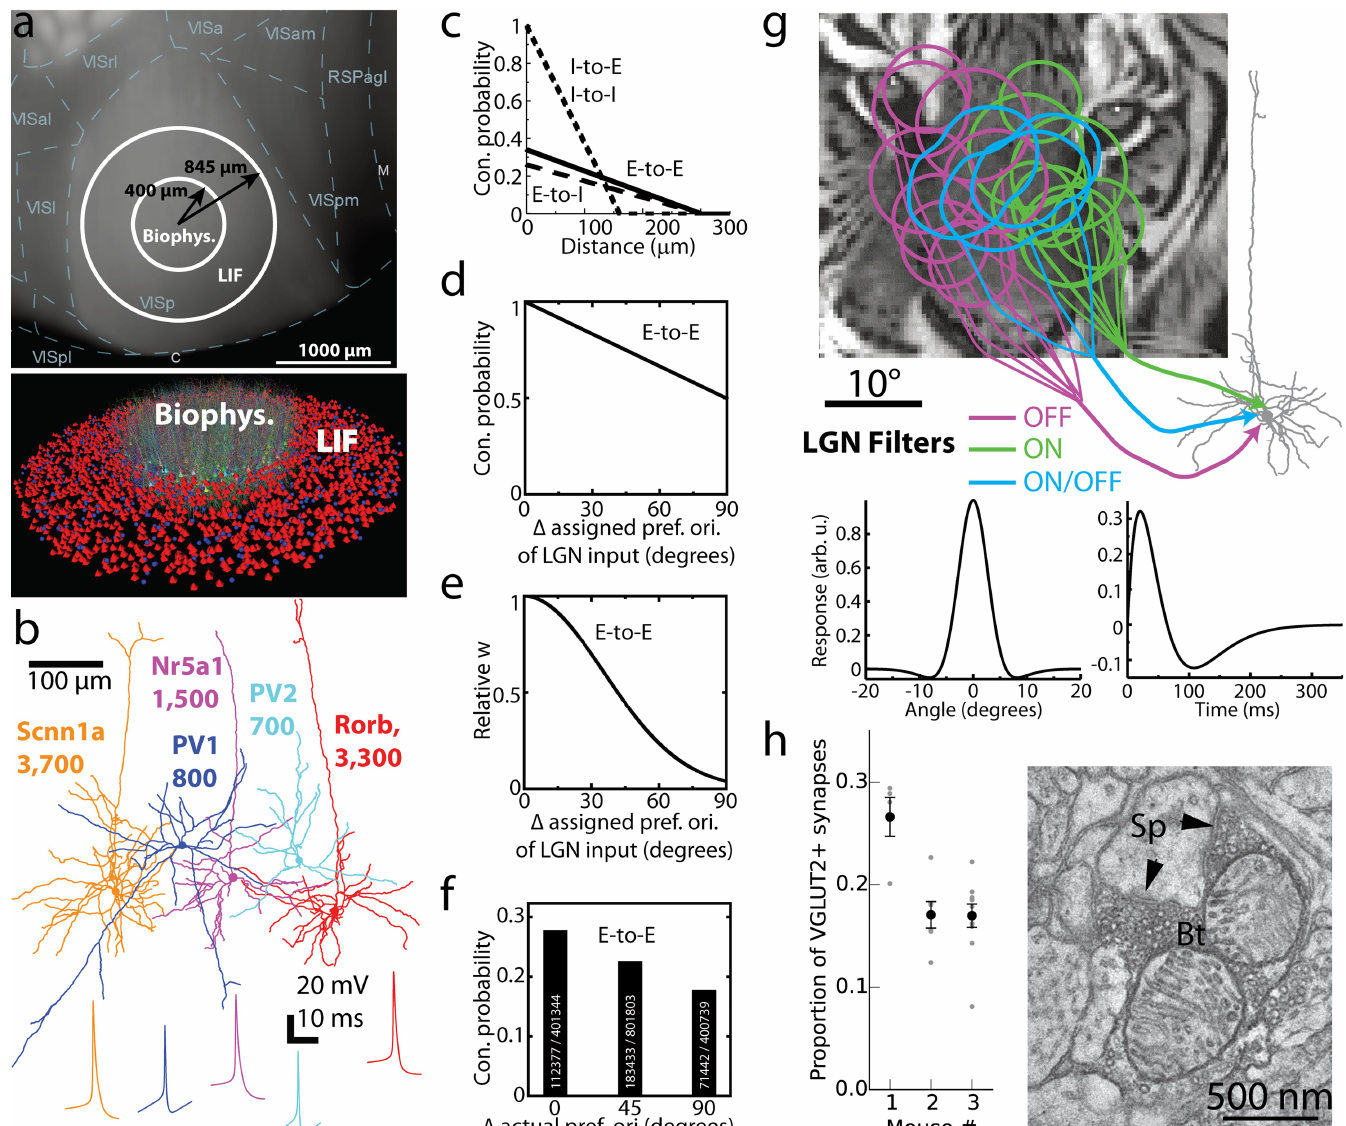
Fig 1. Construction of the model. (a) The biophysical and LIF portions of the model on the cortical surface with delineations of cortical areas (top; “VISp” is V1; the other labels starting with “VIS” correspond to higher visual areas) and with individual cells rendered (bottom; only a small subset of cells is shown for clarity). (b) Morphologies and action potential shapes of the five neuron models used to generate the L4 network; numbers of cells of each type are listed. (c-e) Connection probability (c,d) and synaptic weights (e) of excitatory (E) or inhibitory (I) cell targets and sources. The rules incorporate the dependence on the distance between somata (c) or difference of the assigned preferred orientations, Δ ori (d, e). Rules dependent on Δ ori were applied to E-to-E connections only, and synaptic weights for all connections were independent of distance. (f) Connection probability computed for cells within 50 μ m using actual preferred orientation observed in simulations (cf. [24]). Numbers of connected and total pairs, used to obtain the probability, are shown inside the bars. (g) Three types of LGN filters (ON, OFF, and ON/OFF), superimposed onto an image, providing inputs to a L4 cell. Example filter’s spatial and temporal profiles are at the bottom. (h) The proportion of excitatory thalamocortical synapses (VGLUT2 + ) in the neuropil of V1 L4, as determined experimentally using EM. Proportions for individual samples of tissue are in gray; mean and s.e.m. for each mouse are in black. Right, an exemplar EM image of a putative VGLUT2+ synapse from the LGN onto an L4 neuron (Sp, spine; Bt, bouton; arrows: postsynaptic densities within the